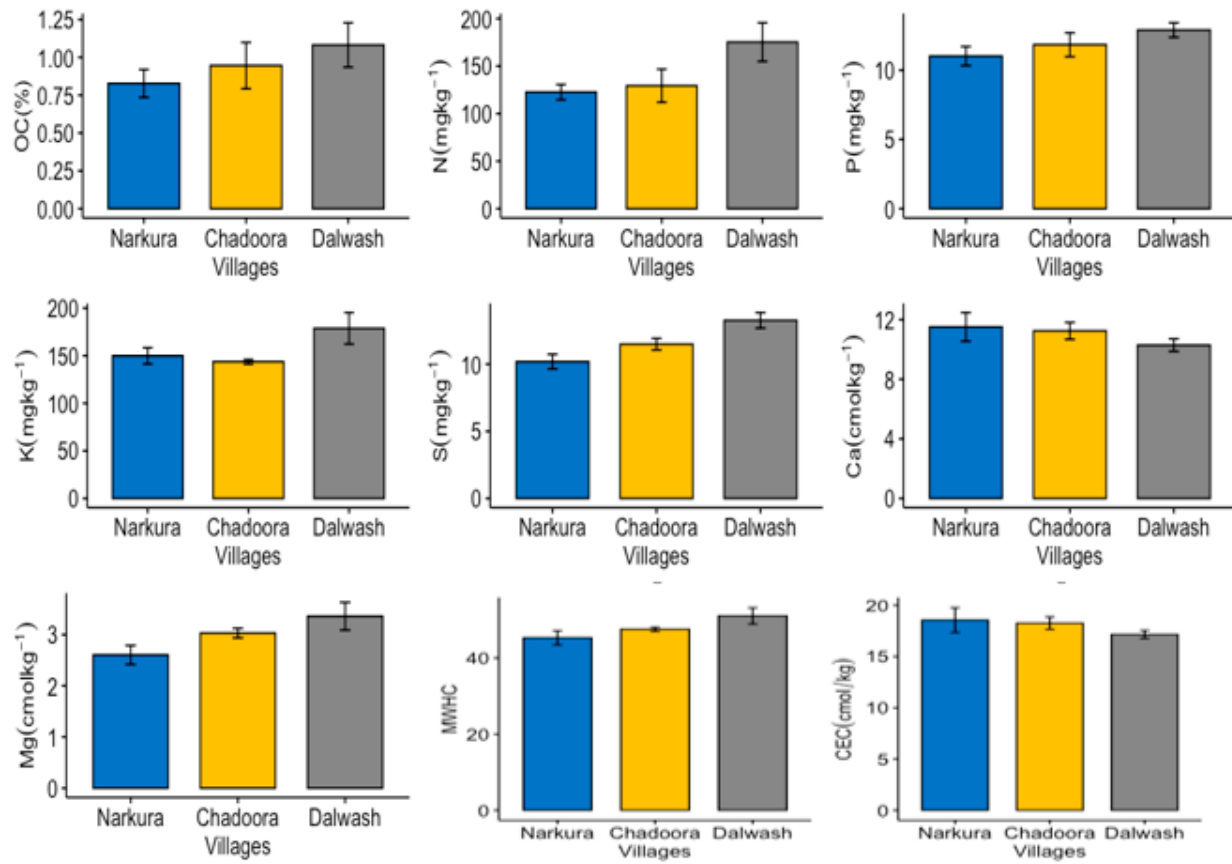
Figure 1. Soil quality indicators of the selected fields in the study villages.